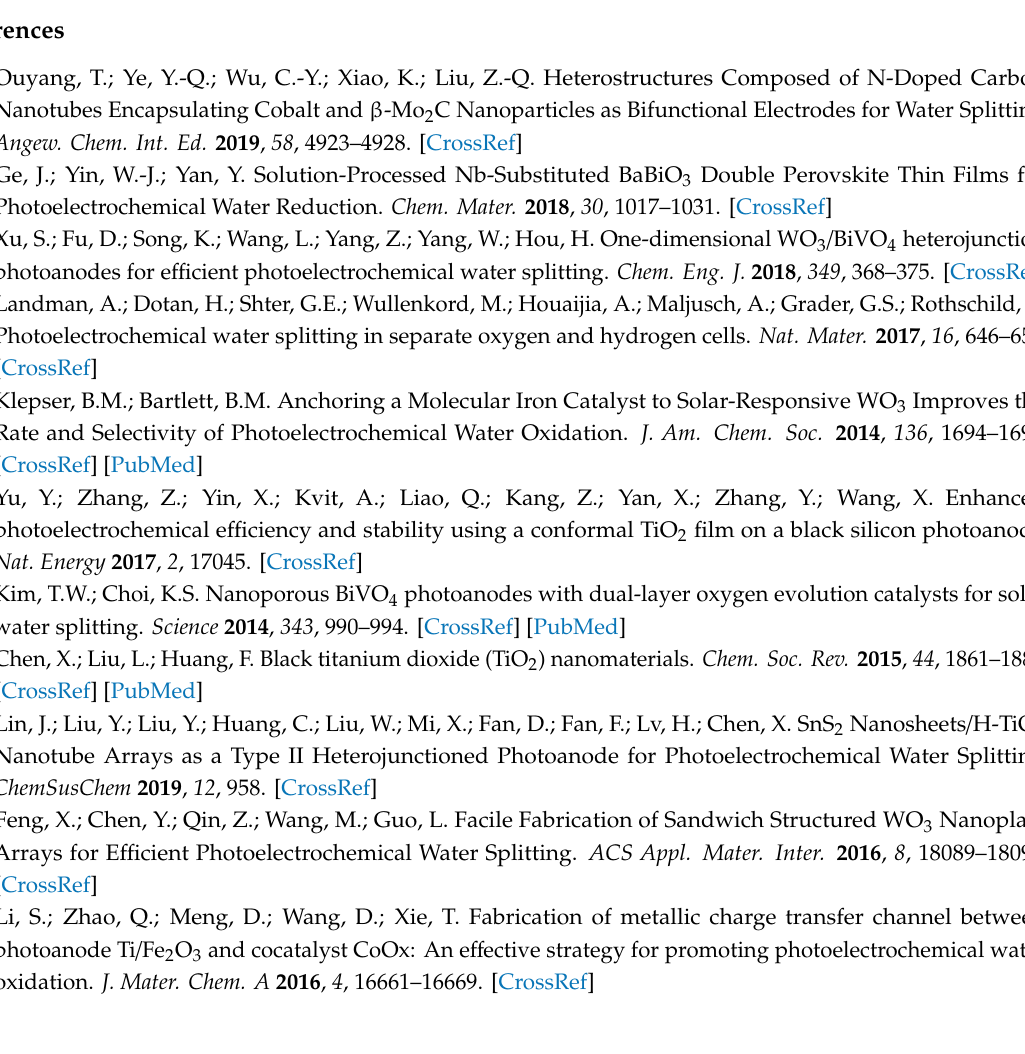
Figure S1: Synthetic Route for N-PDI-P, Figure S2: (a) SEM images of PDI-WO3 composites prepared by immersion for four days and EDS spectroscopy with elemental mapping of (b) C, (c) O, (d) W, and (e) N, Figure S3: XPS spectra: (a) survey spectrum of the prepared N-PDI-P / WO3 composite and high-resolution spectra showing (b) the W 4f7 / 2, W 4f5 / 2 and W 5p3 / 2 peaks, Figure S4: (a) UV-Vis curve and (b) CV curve of N-PDI-P, Figure S5: The Table S1: Decay times measured around the PL peak from time-resolved PL for N-PDI-P on W, N-PDI-P on WO 3 and N-PDI-P / WO 3